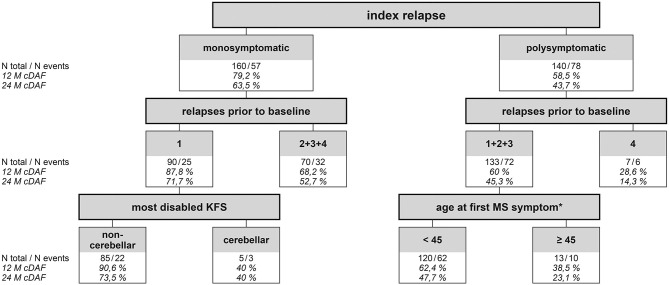
Classification & Regression Tree showing probability of cDAF status for different groups of patients. Statistically strongest factor of clinical disease activity (relapse and/or disability progression) was a polysymptomatic index replase. It divides the entire set of all patients into 2 groups monosymptomatic and polysymptomatic (first level of CART). Twelve-month cDAF shows the probability that the patient will remain without a relapse and disability progression (cDAF status) within the period. 63.5% of patients in the monosymptomatic index relapse group remained in the cDAF status at month 24, compared to 43.7% of patients in the polysymptomatic index relapse group (point 1 of CART). In the monosymptomatic group (n = 160, of which 57 had clinical disease activity within the study period) number of relapses prior to baseline was the strongest predictor of cDAF status (second level of CART), broken down by 1 vs. 2–4 relapses (point 2). Next statistically significant factor within the group of patients with a single monosymptomatic relapse prior to baseline was the most disabled KFS (third level of CART). Cerebellar syndrome as the most disabled KFS was at the strongest risk of clinical disease activity (point 3). In the monosymptomatic group with 2–4 relapses prior to baseline, no other statistically significant factor was found. Within the polysymptomatic group, number of relapses prior to baseline was the next statistically strongest predictor of clinical disease activity broken by 1–3 vs. 4 relapses (point 4). In the polysymptomatic of relapses group with 4 relapses prior to baseline no other statistically significant factor was found The last significant factor fond was within the polysmptomatic index relapse group with 1–3 relapses prior to baseline, which was a factor of age at first MS symptom with a cut off 45 years (point 5). cDAF, clinical disease activity-free; KFS, Kurtzke Functional System (27); MS, multiple sclerosis. *the variable “disease duration” was correlated with variable “age at first MS symptom” and was therefore used a background variable.